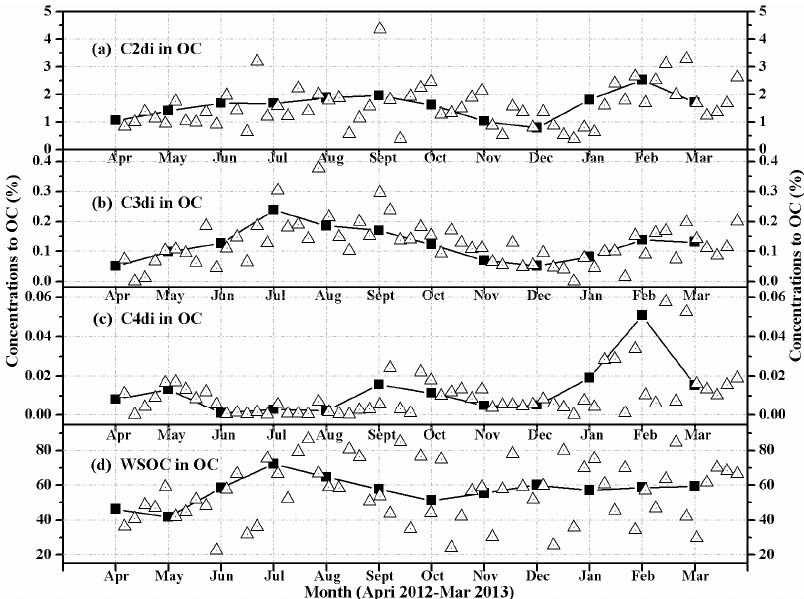
Figure 3. Seasonal variations in the contributions of ( a ) oxalic (C 2 ), ( b ) malonic (C 3 ), and ( c ) succinic (C 4 ) to water-soluble organic carbon (WSOC) in the PM 10 aerosols of Huangshi, Central China. The solid lines indicate monthly mean data points. Atmosphere 2017 , 8 , 213